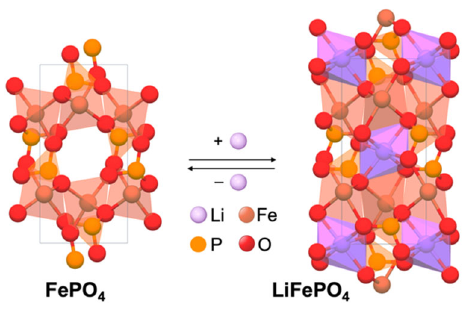
Figure 6. Crystal structure [41] and schematic diagram of the Li-ion de-/intercalation in olivine LiFePO 4 .